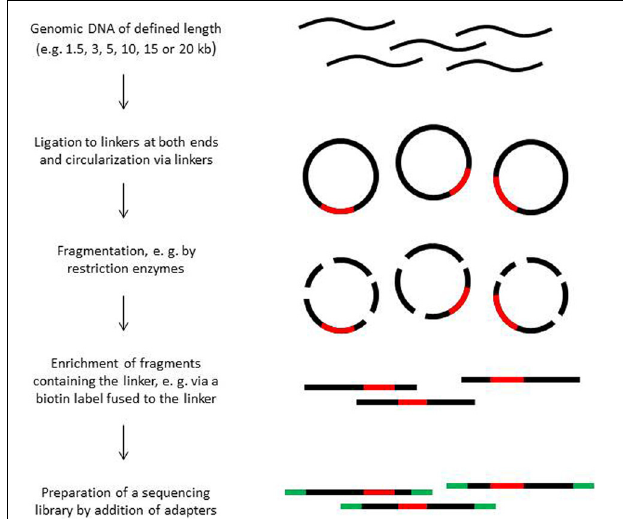
FIGURE 2 | Construction of mate pair